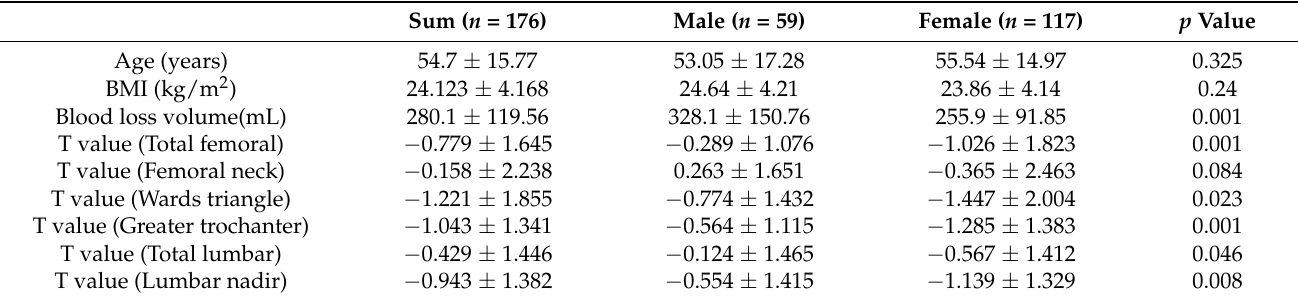
Table 1. Clinical characteristics of the patients undergoing THA.